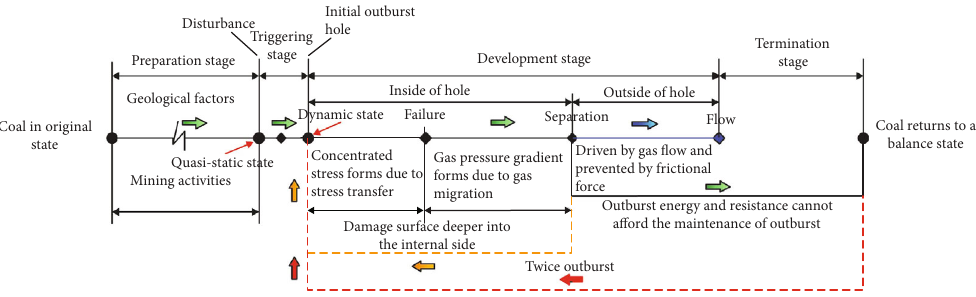
Figure 7: Dynamic stages of coal and gas